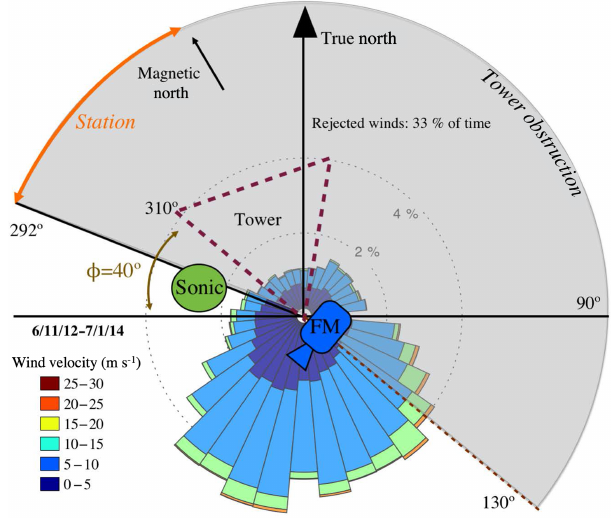
Figure 1. Schematic plan view of the field setup of the FM100 (blue icon labeled “FM”) on the tower (dashed triangle) at Summit Sta- tion. The green oval (“Sonic”) is the position of the Metek sonic anemometer. The grey shaded area shows the wind directions that were rejected and the orange arrow denotes the sector facing the station. The wind rose is also shown cantered on the FM